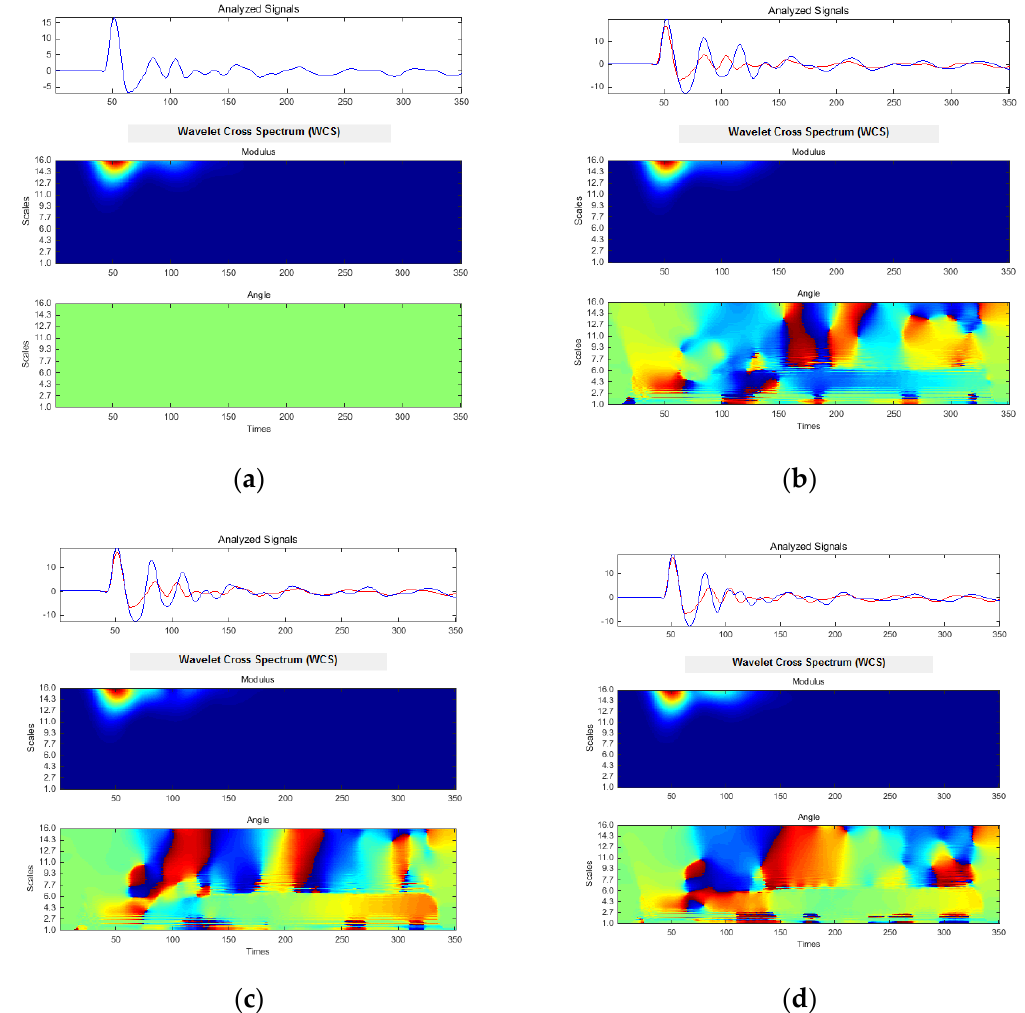
Figure 15. Modulus and phase of complex wavelet cross-spectrum: ( a ) Case 1 related itself; ( b ) Case 2 related to Case 1; ( c ) Case 3 related to Case 1; and ( d ) Case 4 related to Case 1. Each pair of inspected signals is also depicted. Horizontal axes denote instant sample number.